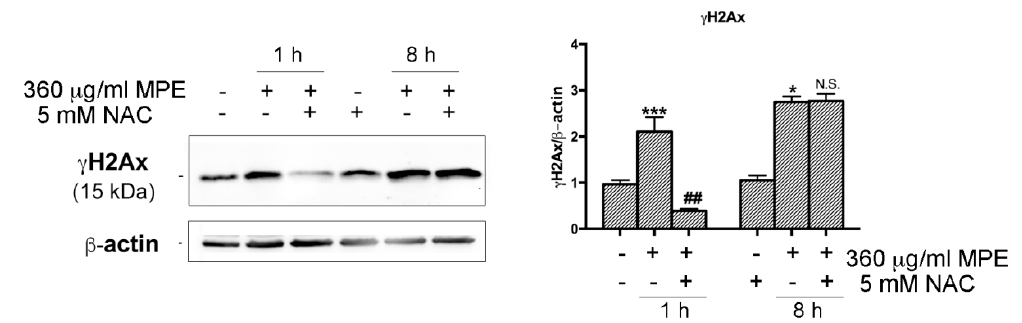
Figure 9. MPE promotes early activation of γ H2AX via oxidative stress. HT29 cells were treated with MPE for the indicated times in the presence or absence of NAC. Lastly, western blotting analyses were performed in order to study the effects of the treatments on the total level of γ H2AX. The correct protein loading was ascertained by immunoblotting for β -actin. The results are representative of three independent experiments and densitometry analysis histograms are reported normalized to β -actin. (*) p < 0.05 and (***) p < 0.001 compared to the untreated sample. (##) p < 0.01 compared to MPE-treated sample. N.S., not significant compared to MPE-treated cells.